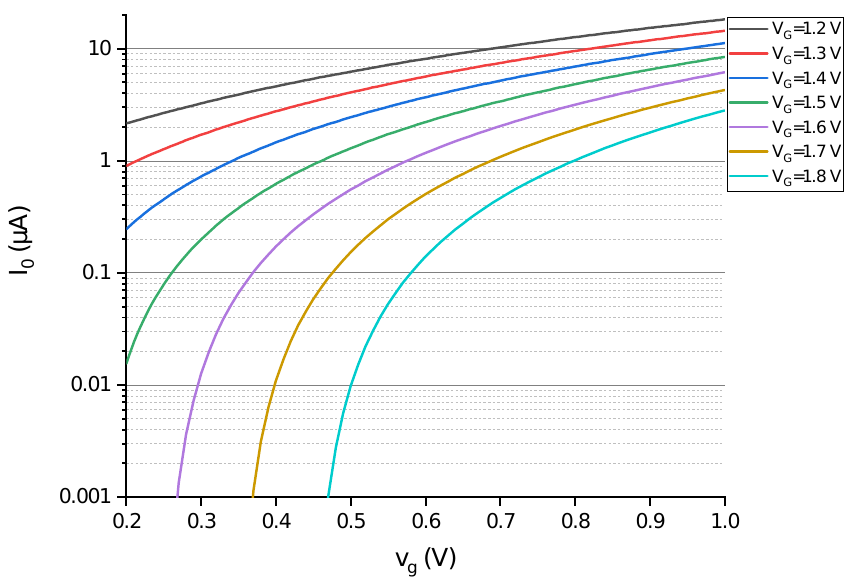
Figure 6. Calculation results of I 0 .